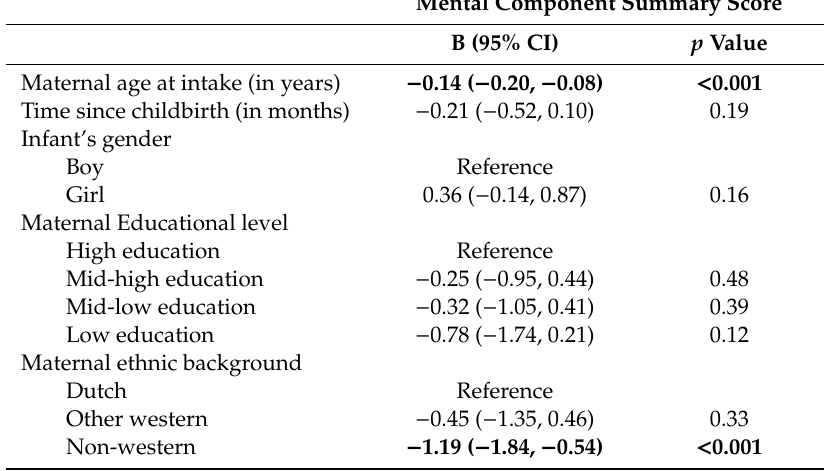
Table 2 is based on the imputed dataset. Values represent betas with 95% CIs (confidence intervals) and p values derived from multiple linear regression analyses. Bold print indicates the statistical significance. The significance level is p < 0.05. 1 Maternal psychopathology was measured by the brief symptom inventory. Table 3. Multivariable associations with mental component summary score in the imputed dataset ( n =